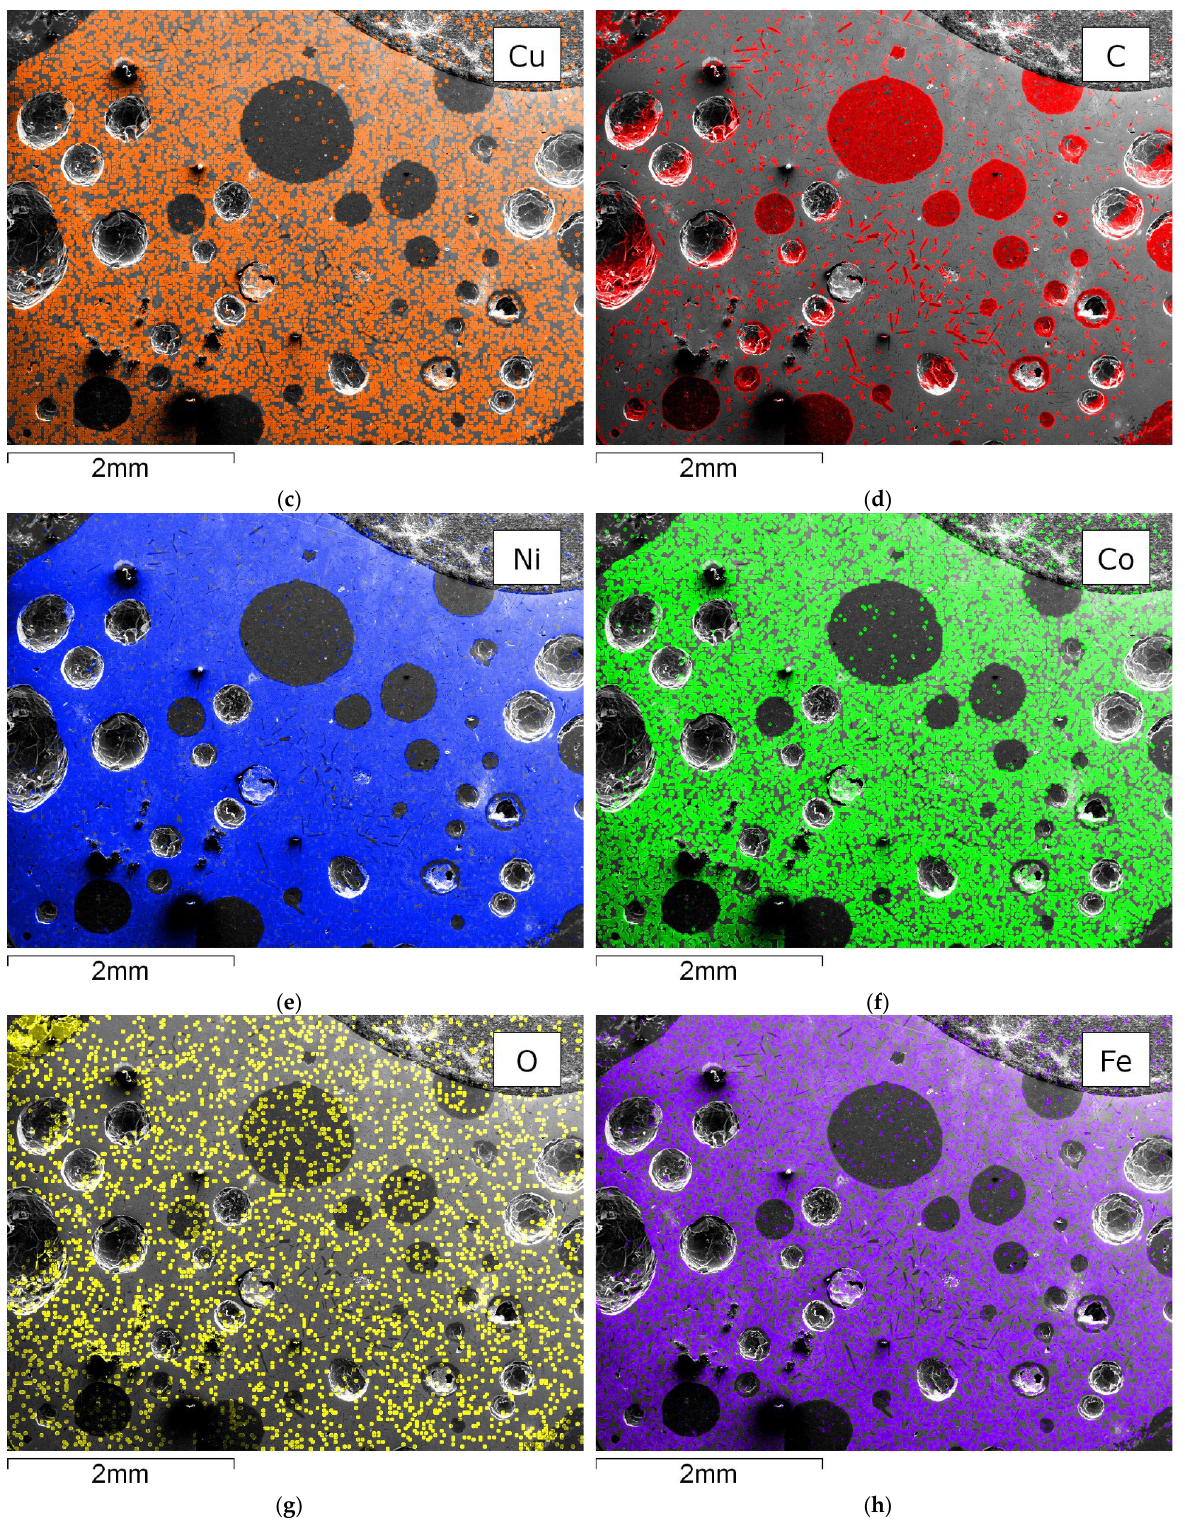
Figure 9. SEM picture and overlay of the elemental distribution of characteristic elements; ( a ) SEM picture of the metal after InduMelt experiment; SEM-EDX mapping of ( b ) aluminum; ( c ) copper; ( d ) carbon; ( e ) nickel; ( f ) cobalt; ( g ) oxygen; ( h )